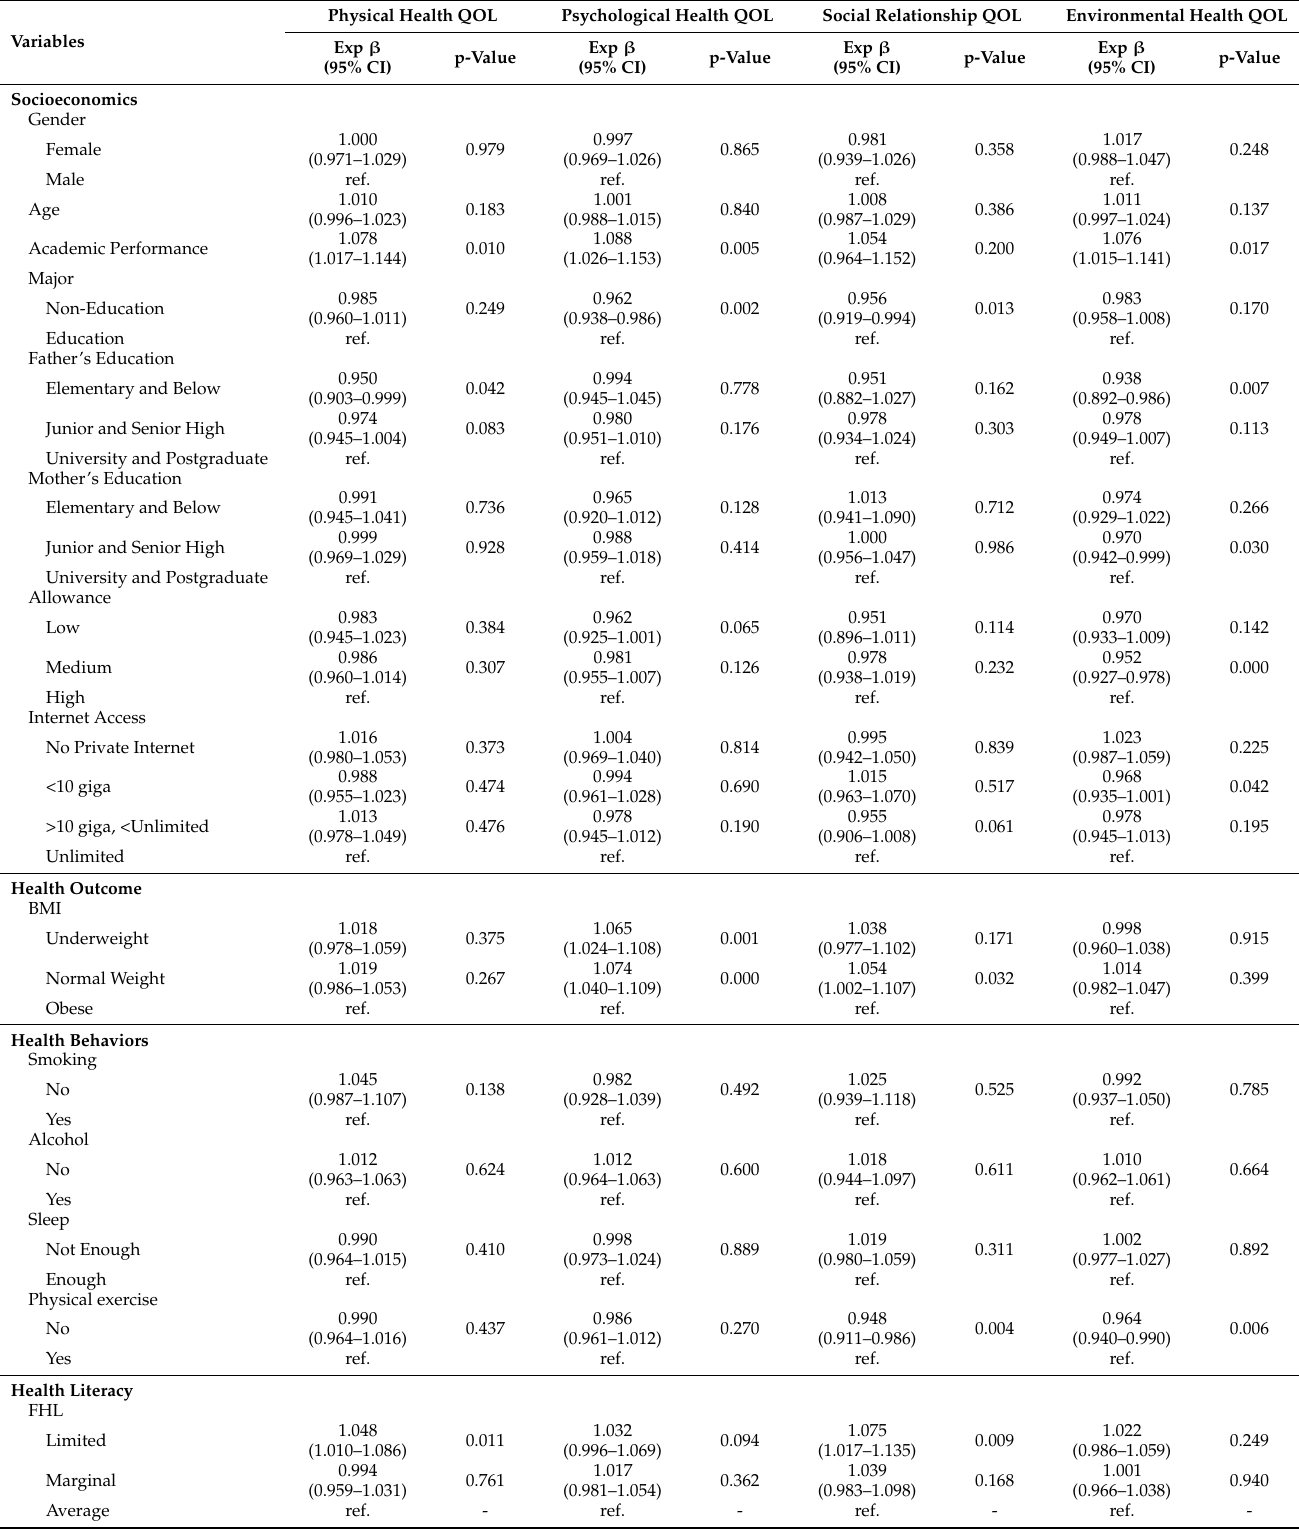
Table 4. Multivariate GLM gamma log-link for the four domains of QOL with FHL in addition to socioeconomic determi- nants, HBs, and